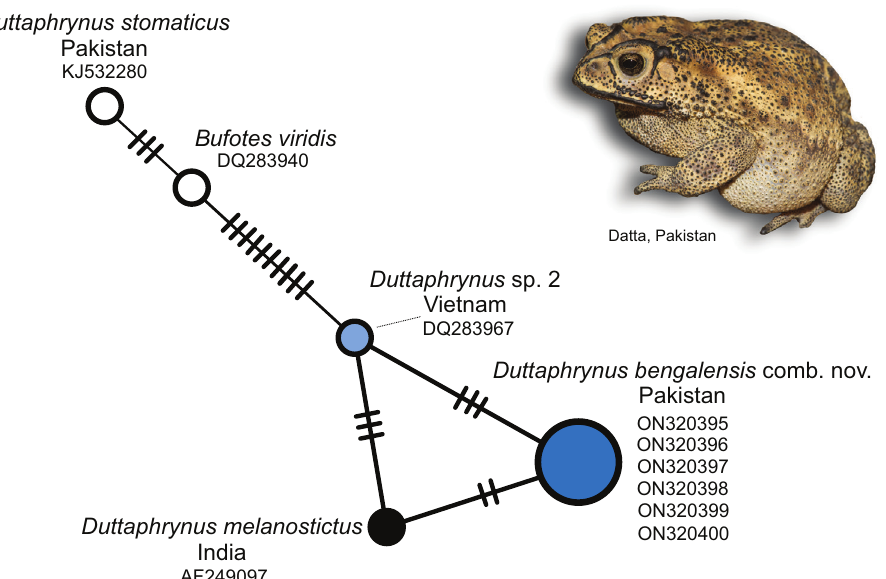
Figure 3. Median-joining alleles network of sequences from the Duttaphrynus melanostictus complex and closely related members of western Palearctic Bufonidae based on rhodopsin ( Rho ) gene available in GenBank and from own data. The colors correspond to those used in Fig. 1. Note, the origin of sequence AF249097 from India cannot be assigned due to unknown geographic details. The pictured individual represents a population of Duttaphrynus bengalensis comb. nov. (Daudin, 1802) from Datta, Mansehra,